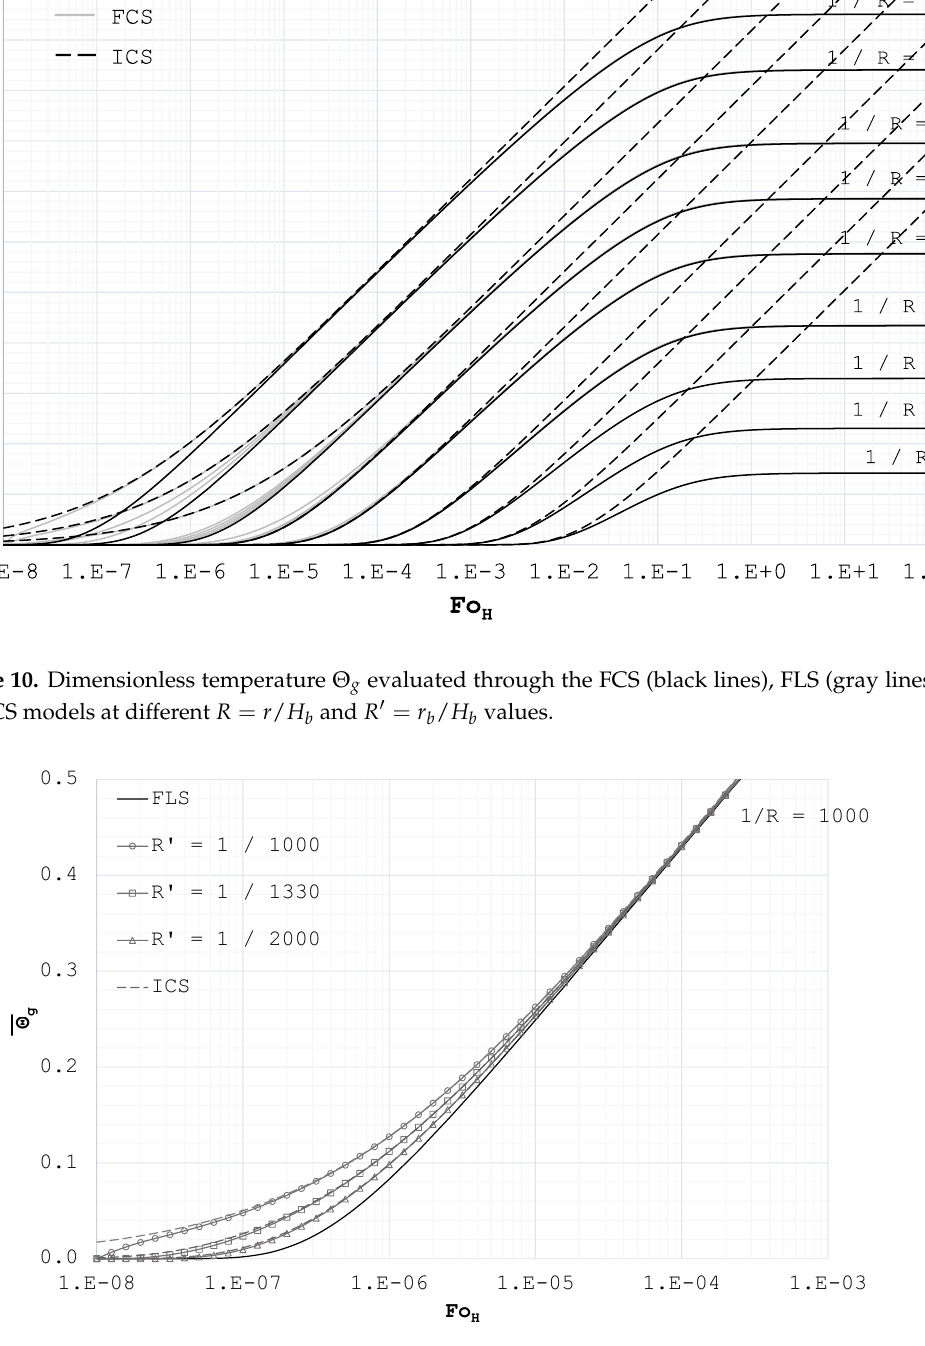
Figure 11. Dimensionlesstemperature Θ g evaluatedthroughtheFCSandFLSmodelsfor R = r / H b = 1/1000. It is possible to define a “critical” value, Fo H , c , as a function of R (cid:48) and R , beyond which FCS and FLS models become practically equivalent. Here, we consider Fo H , c as the Fourier number after which the relative difference between FCS and FLS models is less than 5% (see Figure